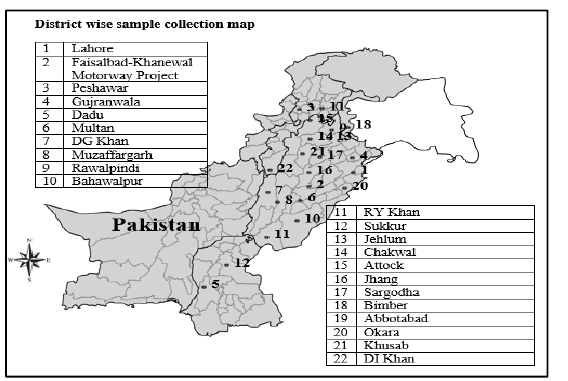
Fig. 1: Soil Sample Collection